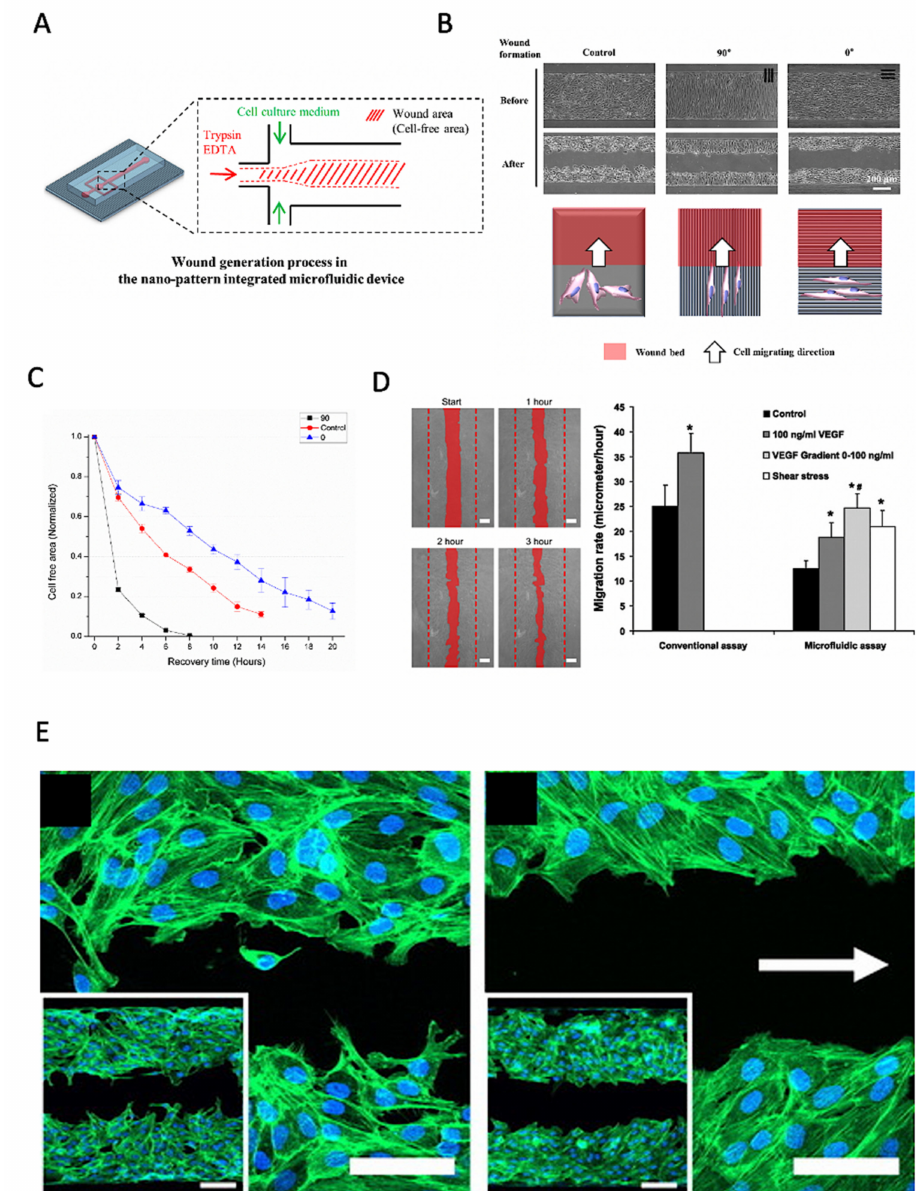
Figure 5. Enzymatic microfluidic wound healing assays based on the laminar flow patterning of fluids. ( A – C ) Influence of the on-chip nanopattern direction on wound healing speed using enzymatic depletion of a central cell-free area using trypsin. Adapted with permission from [48]. ( D , E ) Influence of flow direction, shear, and VEGF on ( E ) endothelial migration rate and ( D ) wound healing directionality. (* Significant increase compared with control values (Student’s t -test, p < 0.05). # Significant increase compared with 100 ng/mL VEGF165 treatment (Student’s t -test, p < 0.05). Adapted with permission from ref. [49]. 2021,